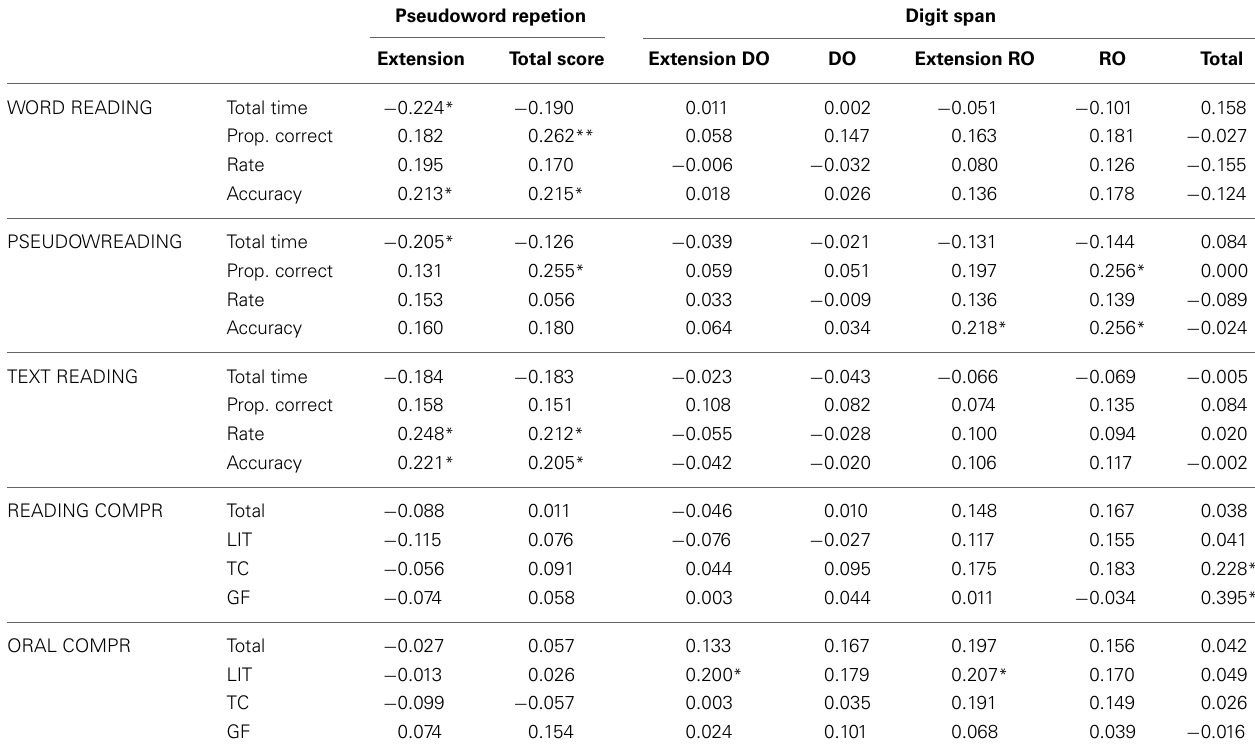
Table 4 | Correlations between variables—Comparison